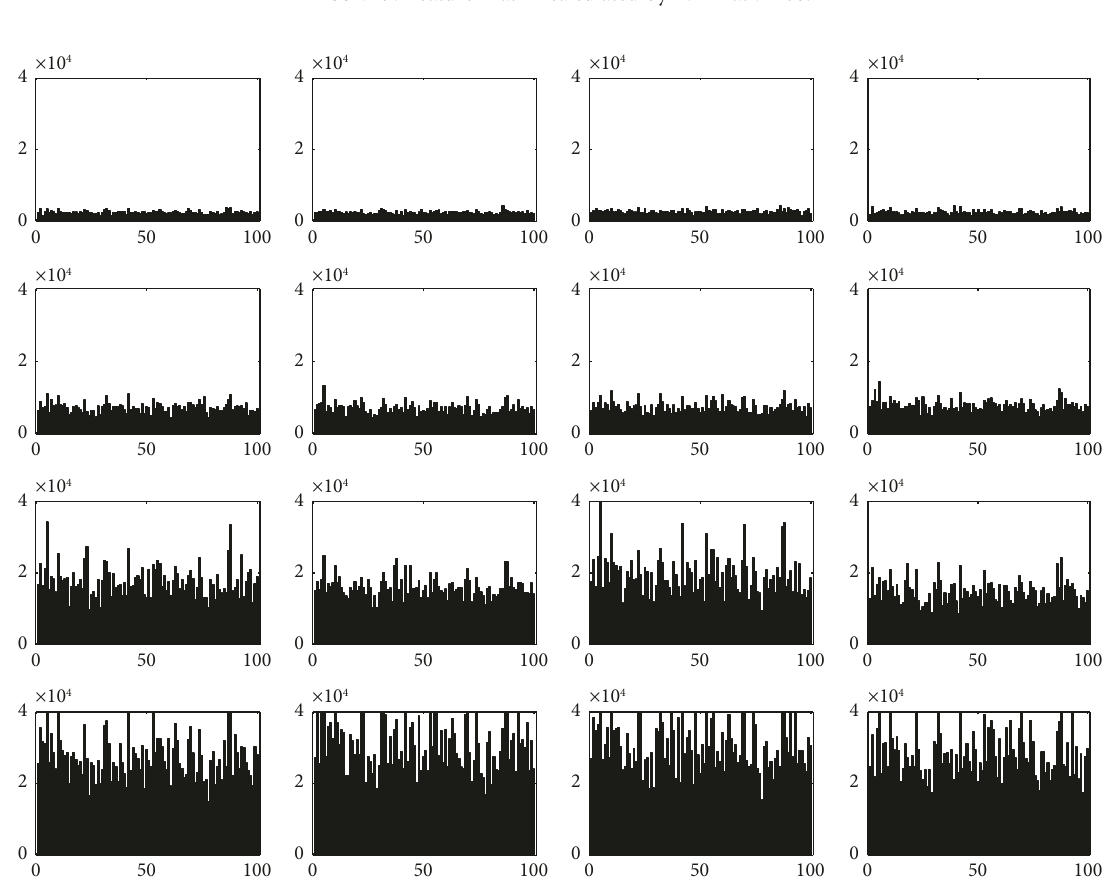
Figure 10: Feature matrix calculated by NMF at r � 100.